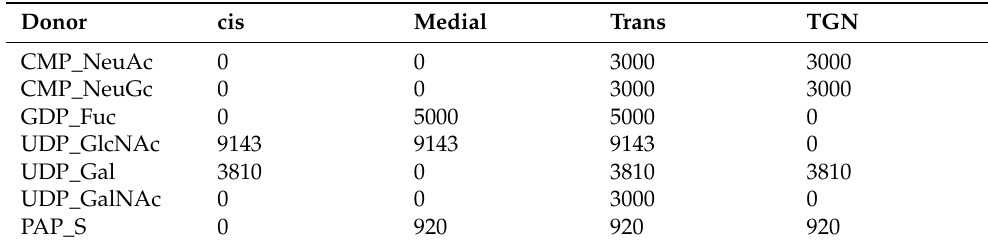
Figure 2. Glycosyltransferases included in modeling the O -glycan profiles of the 25 CHO cell lines. Dark grey represents the glycosyltransferases transiently expressed in the cells. Light grey represents the reactions of the glycosyltransferases required to produce a glycan profile. White cells represent enzymes that were neither transfected nor required for the glycan profile synthesis. C1: core 1; exC1: extended core 1; C2: core 2; C3: core 3; C4: core 4. “_a, _b” represents different reactions (reaction rules) catalyzed by a glycosyltransferase. Table 3. Donor concentrations in µ M and distribution across the Golgi